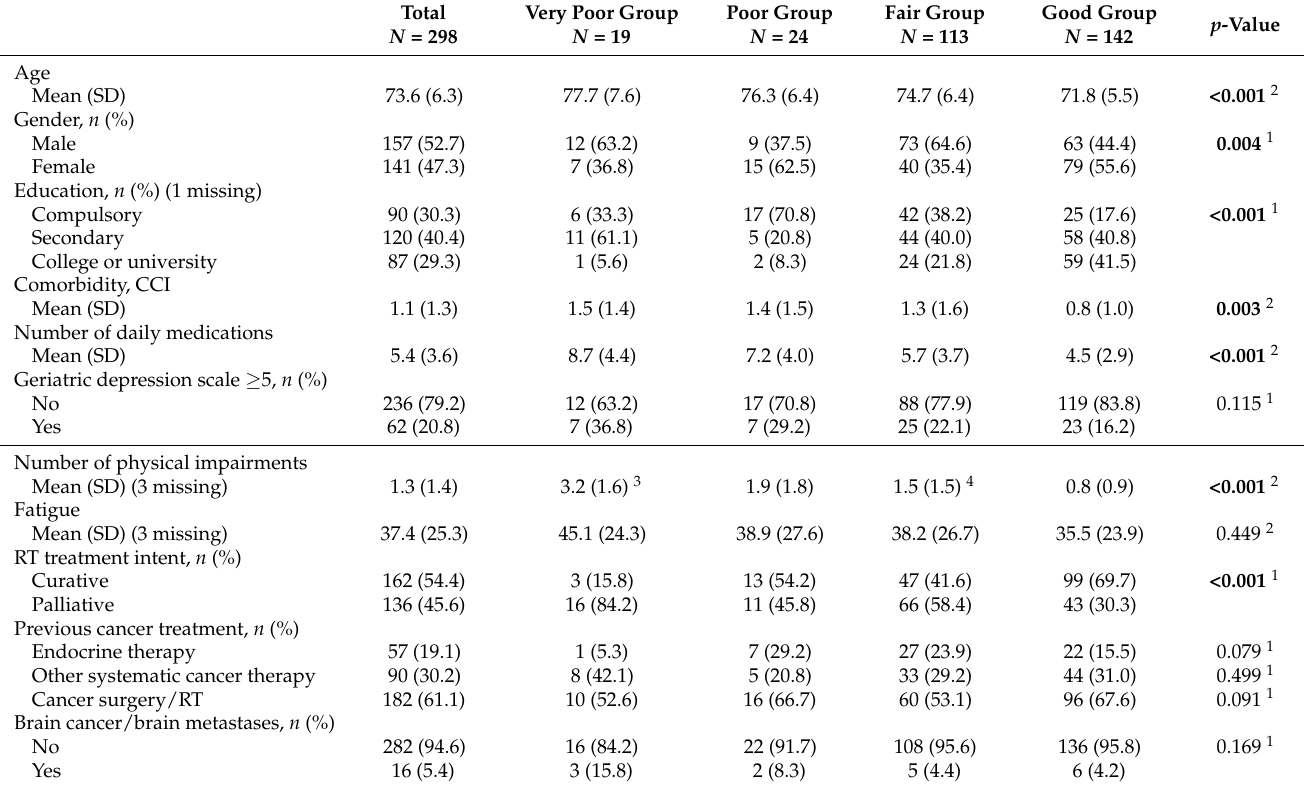
Table 1. Baseline patient characteristics and factors with potential influence on baseline MoCA scores, in total and according to groups with distinct MoCA score trajectories.